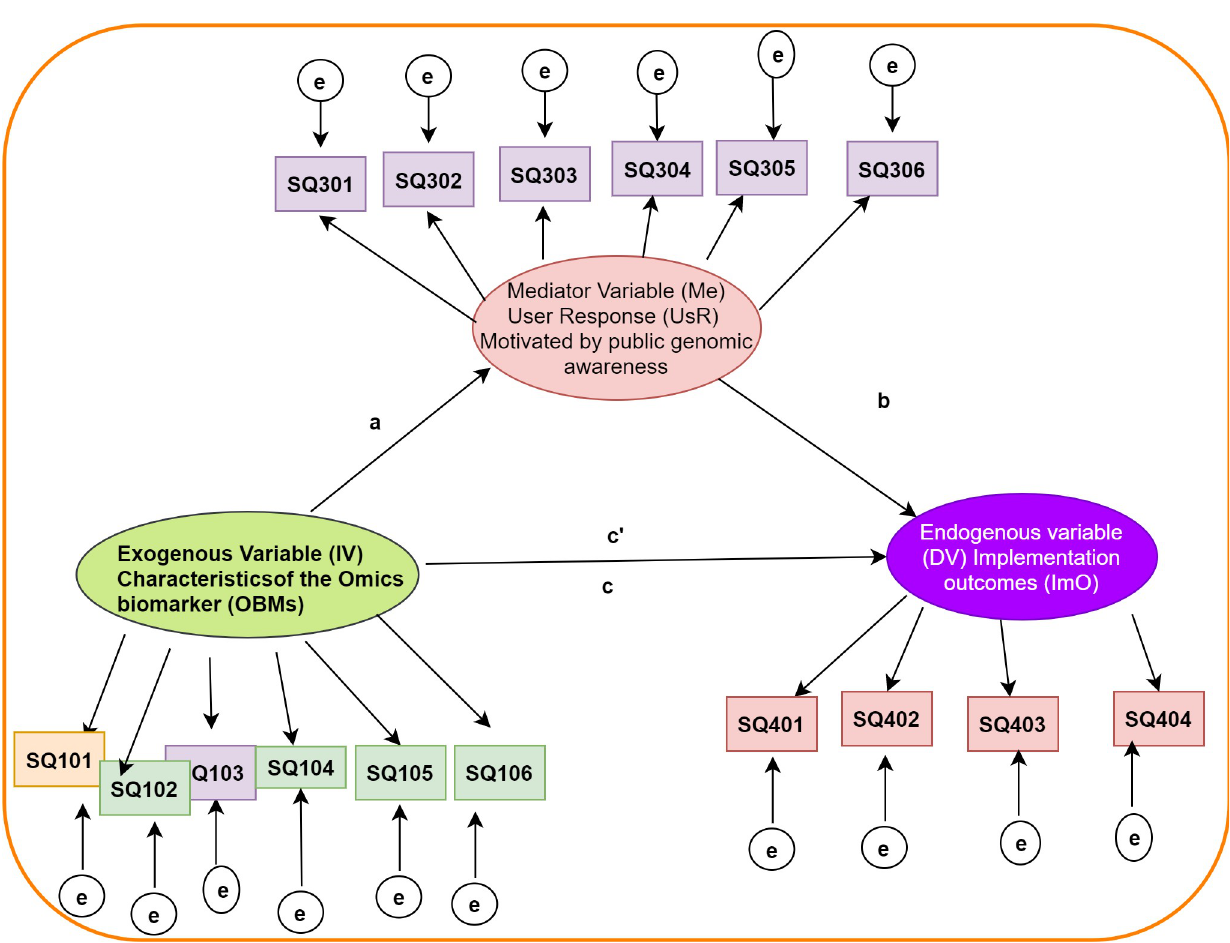
Fig 2. Hypothesized systems level precision medicine implementation mediation model. Key: Large oval shapes = latent (unobservable) factors; Rectangles = indicator (observable) variables; Arrows = hypothesised correlation direction; Small circles = residual errors explaining measurements errors; Me = the mediator variable, a = the effect size of the independent variable on the mediator, b = the effect of the mediator on the dependent variable controlling for X, and c’ = the direct effect of X on Y controlling for Me.